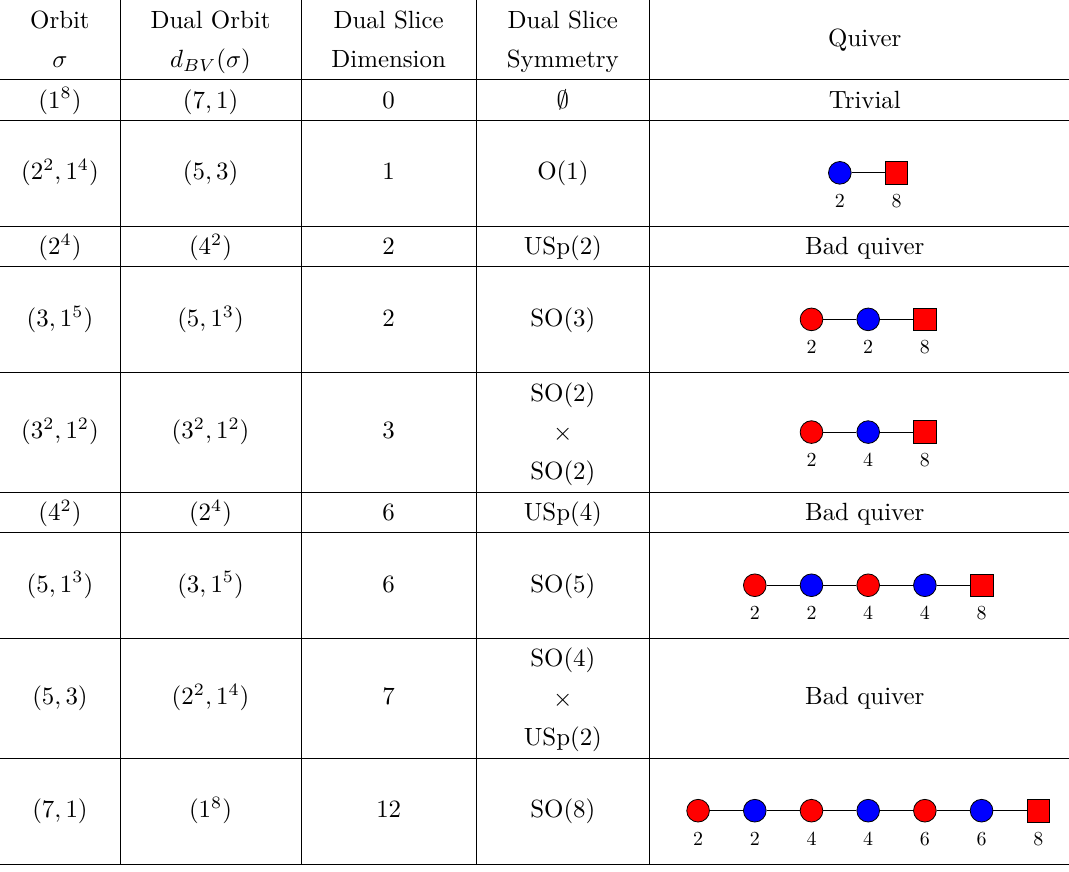
T (SO(8)) linear quivers. These are used in untwisted D 4 fixtures. The quivers T (SO(8)) have non-diverging monopole formula; bad quivers with zero conformal dimension d BV ( σ ) are not shown. The partitions identify special orbits of SO(8)